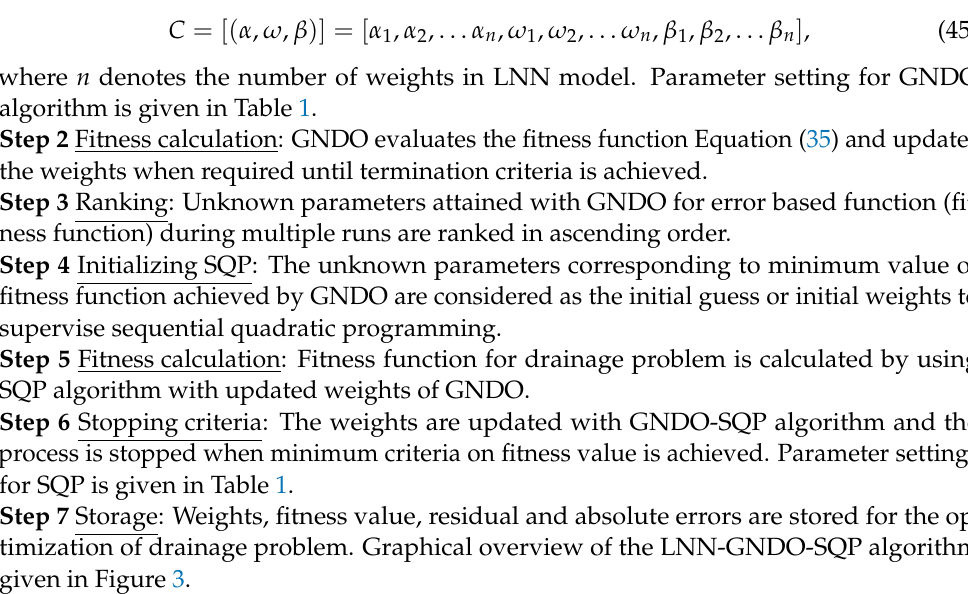
Table 1. Parameter settings for GNDO and SQP algorithms.